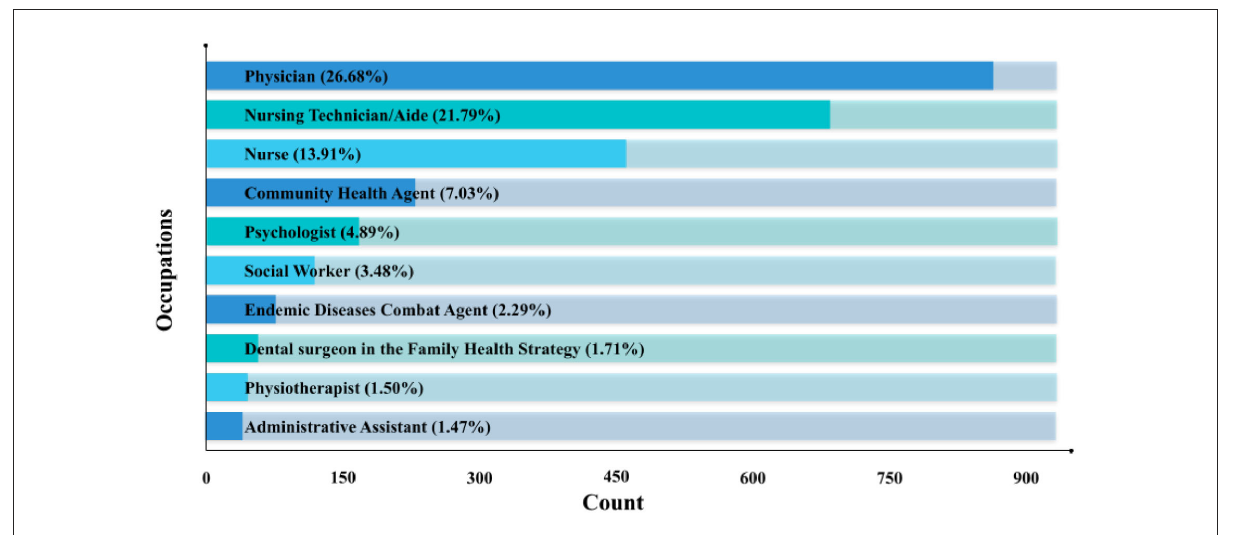
FIGURE4 Distribution of occupations among course